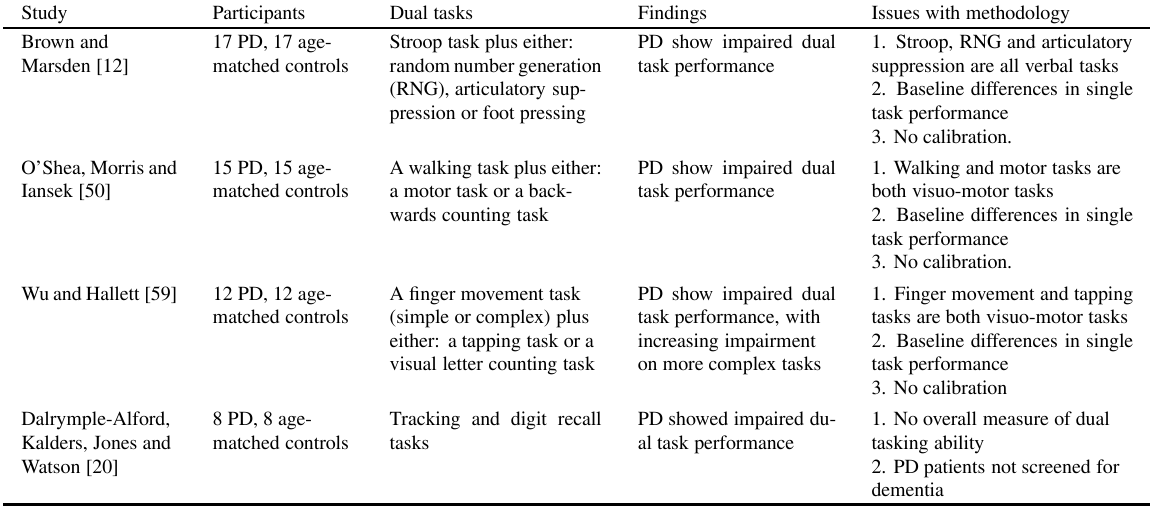
Table 1 Studies investigating dual tasking in